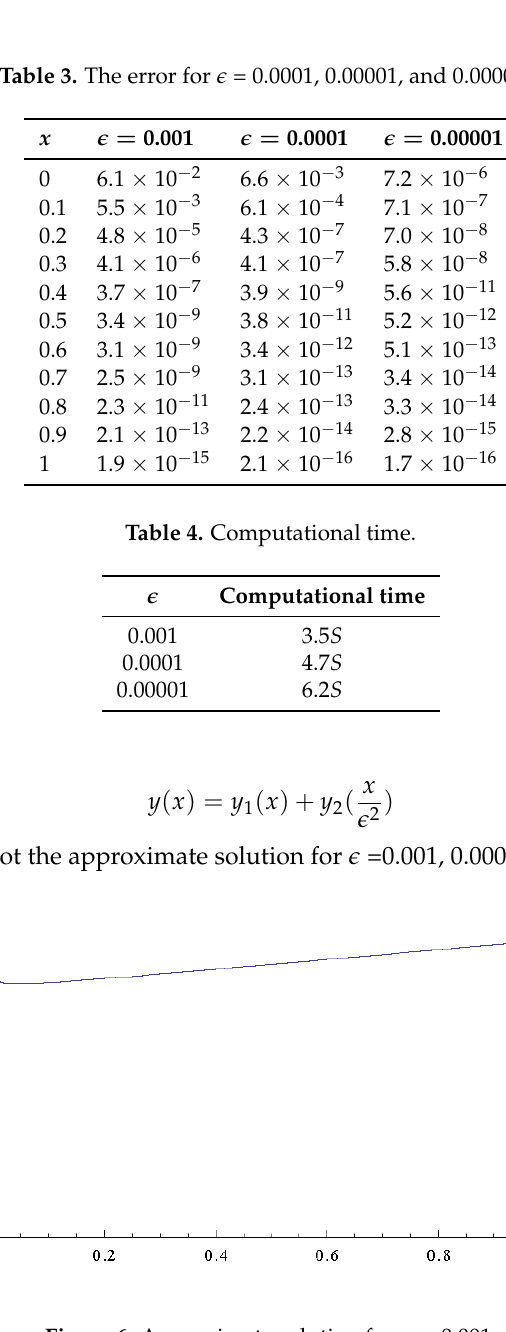
Figure 6. Approximate solution for (cid:101) =